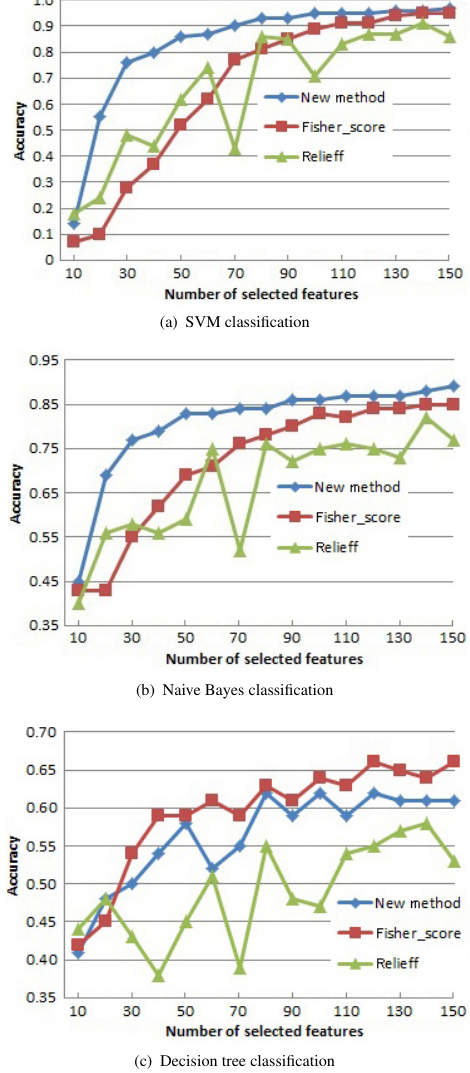
Fig. 5 Performance comparison of new FS with supervised FS on ORL image